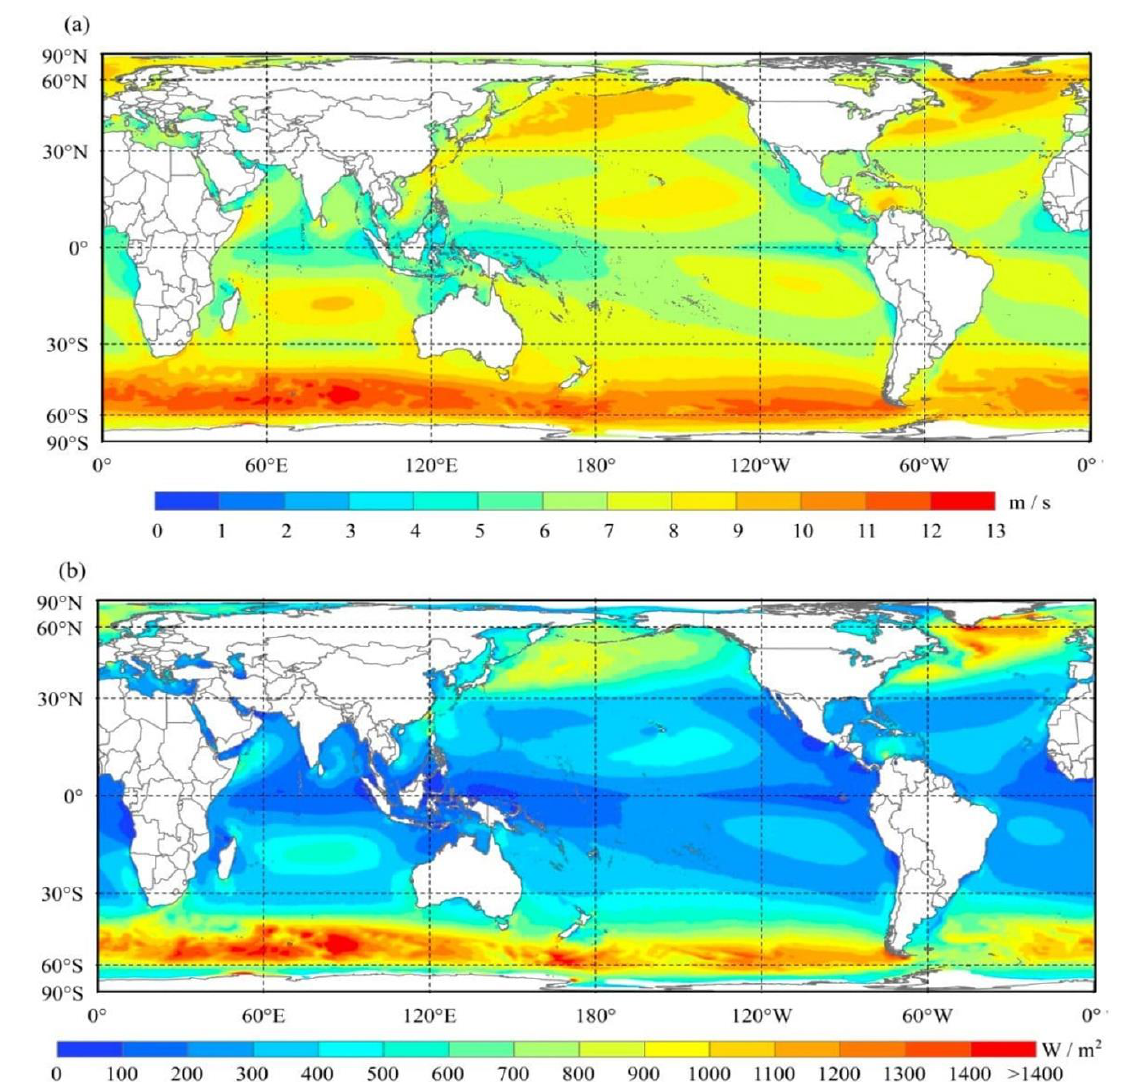
Figure 2. The spatial distribution of the global mean ( a ) OSW speeds and ( b ) wind power densities at 10 m above SL derived by a combination of QuikSCAT, Windsat, and ASCAT datasets from 1999 to 2015. The figure is directly adopted from Ref. [103].